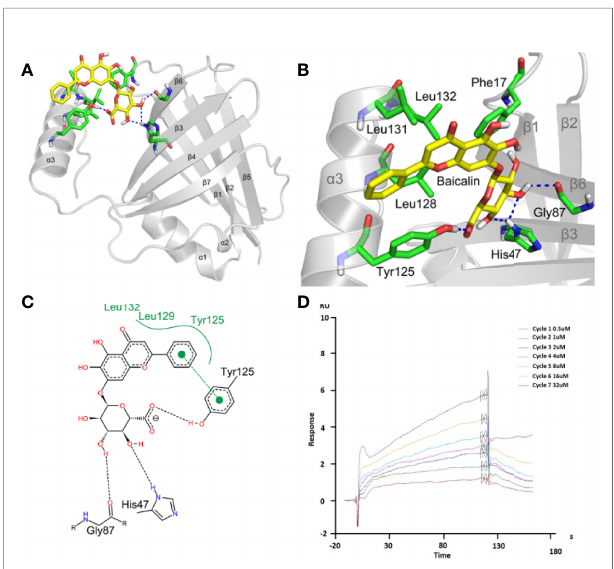
FIGURE 5 | Baicalin binds to viral NS1 protein with high af fi nity. (A-C) Analysis of the interaction between baicalin and NS1 protein. The yellow stick indicates baicalin, the green stick indicates the interacting amino acids, and the blue dashed line indicates hydrogen bonding (A, B) . The black dotted line represents the hydrogen bonding, the green solid line the hydrophobic interaction, and the p - p stacking is represented by solid circles and dashed lines (C) . (D) Surface plasmon resonance (SPR) analysis of baicalin binding to viral NS1 protein. NS1 was coupled to the CM5 chip. Representative response curve of NS1 and baicalin binding is